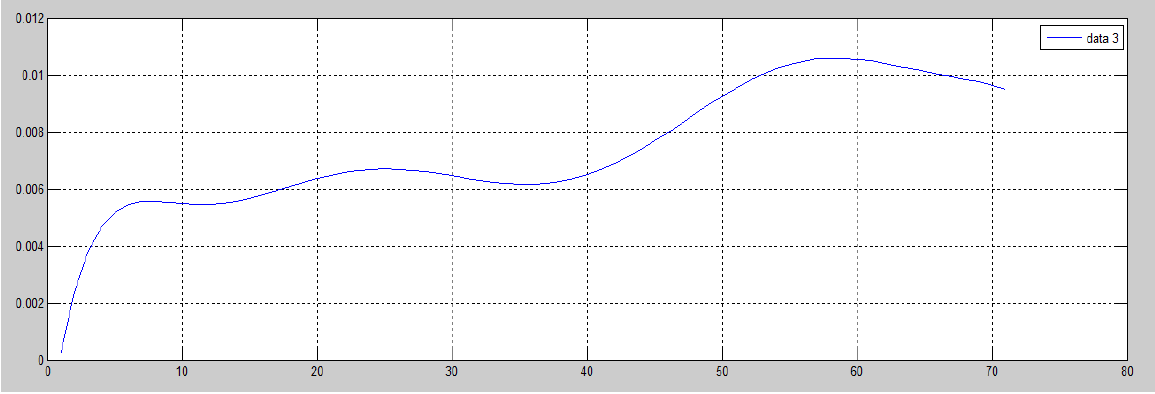
Figure 10. The curve of the difference of the elevations between two models